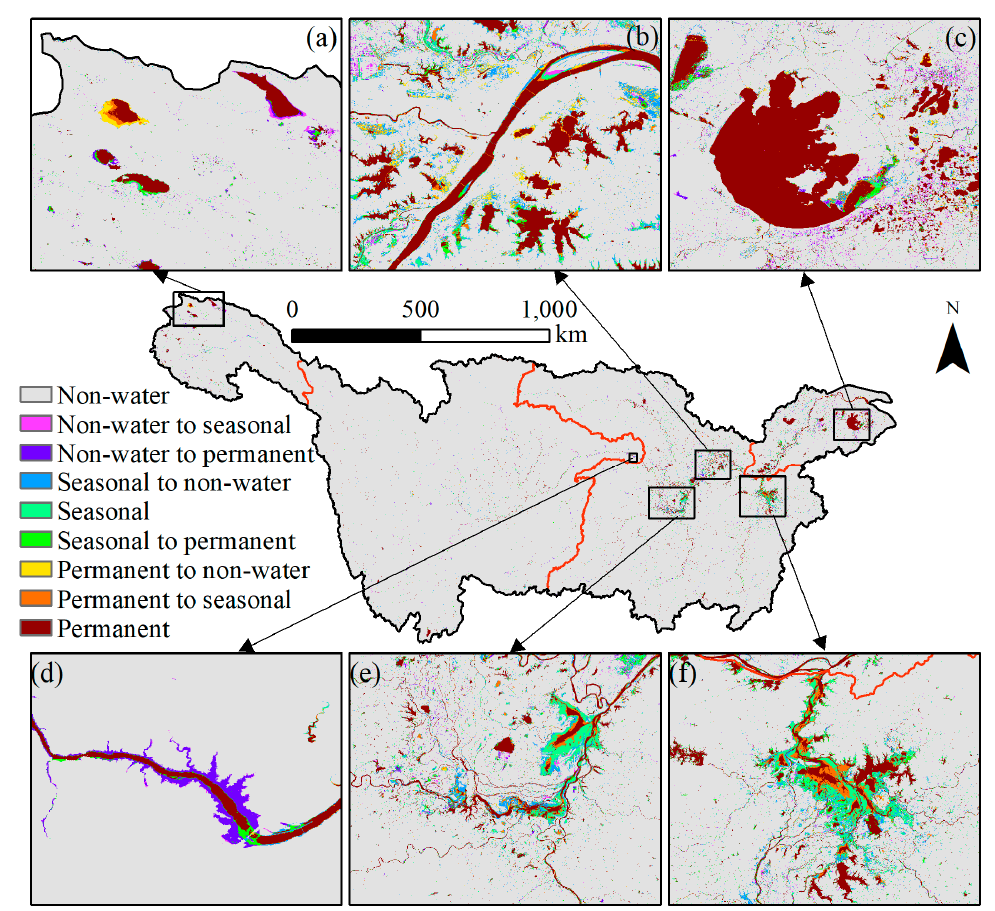
Figure 11. The spatial pattern of conversion of surface water bodies from 1984 to 2018 in the YRB. ( a – f ) indicates the source regions of the YRB, Wuhan city, Taihu Lake, the Three Gorges Dam (TGD), Dongting Lake and Poyang Lake, respectively.